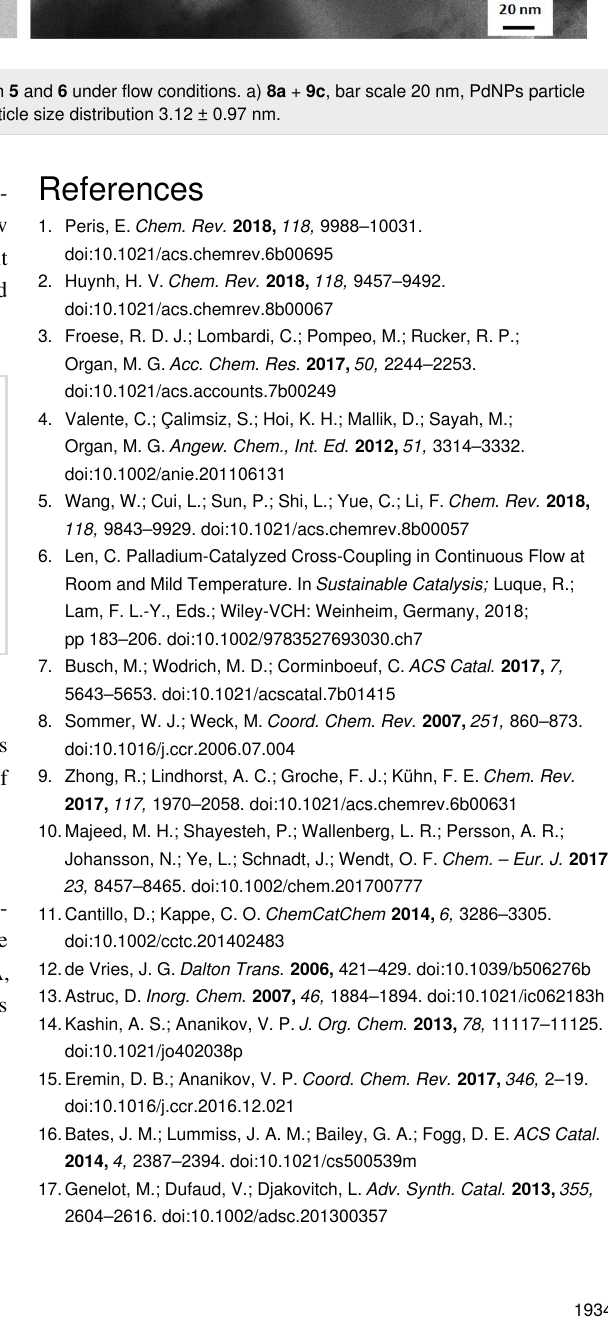
Figure 9: TEM images of the polymer after the Negishi reaction between 5 and 6 under flow conditions. a) 8a + 9c , bar scale 20 nm, PdNPs particle size distribution 4.72 ± 1.44 nm. b) 8a + 9a bar scale 20 nm, PdNPs particle size distribution 3.12 ± 0.97 nm.